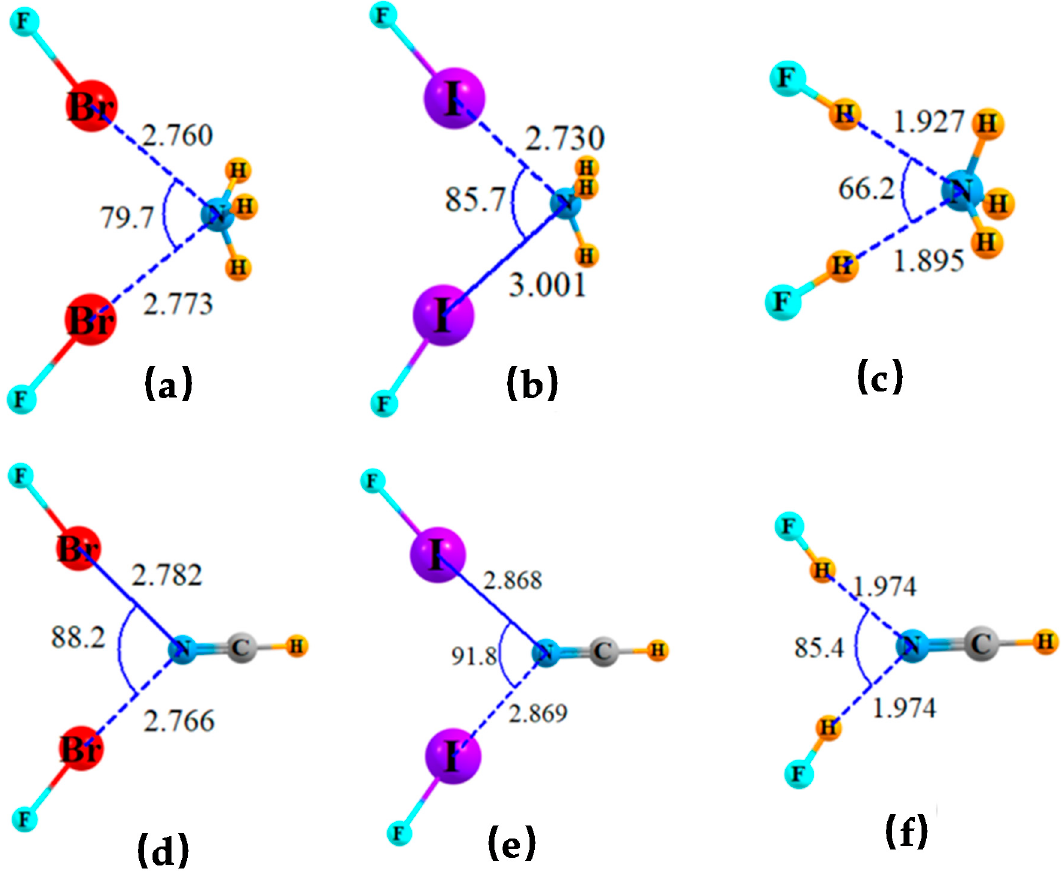
Figure 2. Geometries of triads wherein a pair of Lewis acids share a single lone pair of NH 3 or NCH, optimized with constraint of equal θ (X ·· N ·· X) angles. Distances in Å and angles in degs. NH 3 is shared by two ( a ) FBr, ( b ) FI and ( c ) FH. NCH is shared by two ( d ) FBr, ( e ) FI, and ( f ) FH.